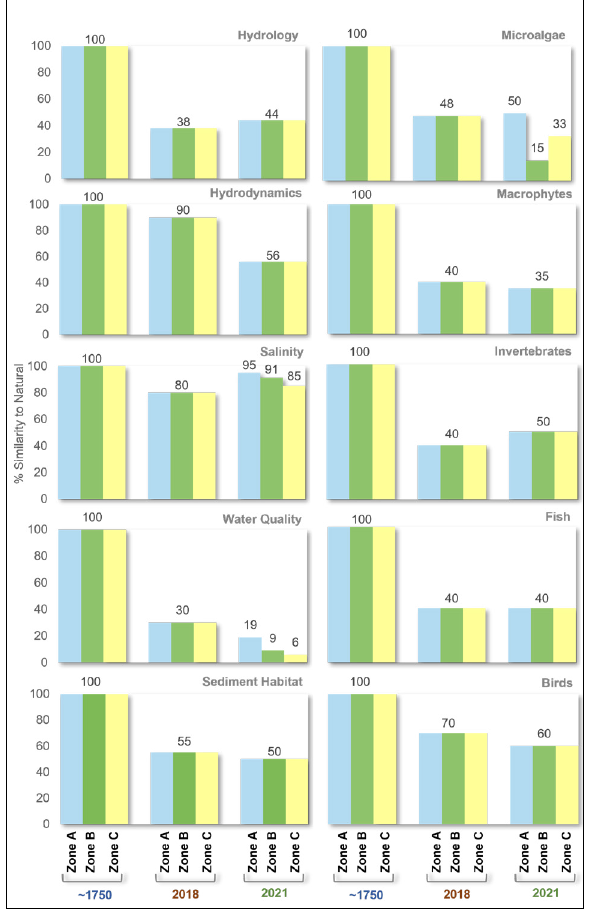
Figure 3: Change in condition in selected abiotic and biotic indicators across Zones A, B and C in the Swartkops Estuary between ~1750 (natural), 2018 and